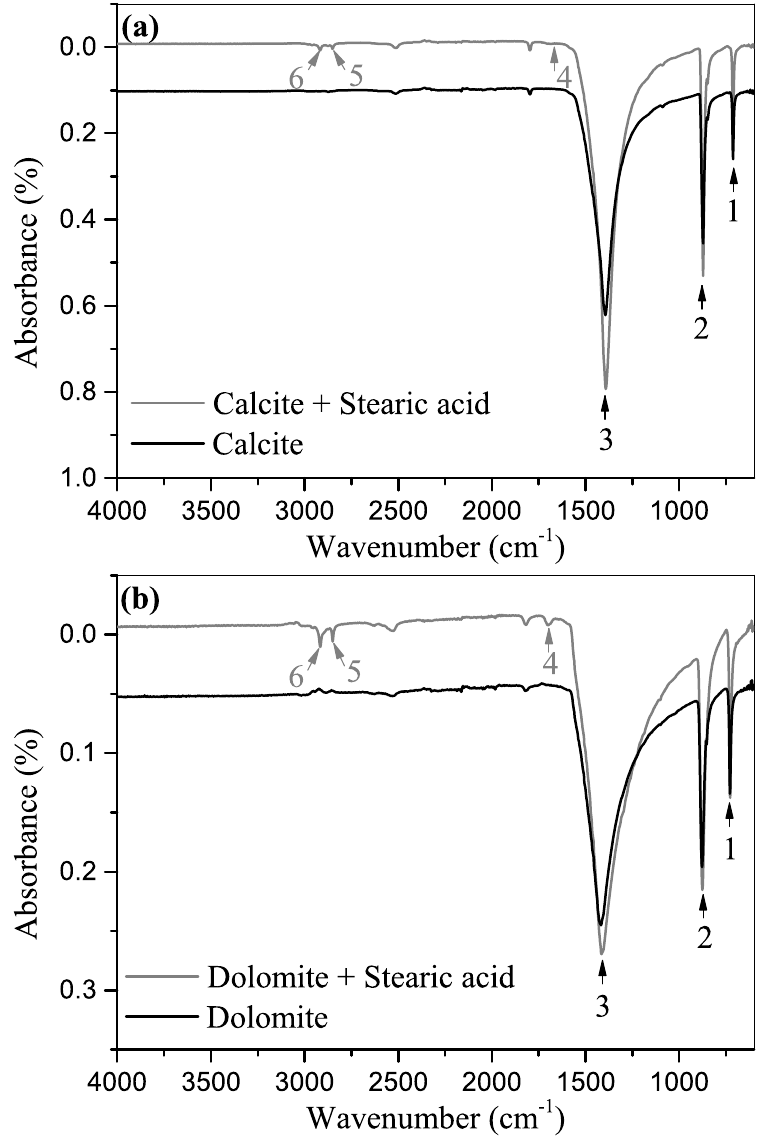
Figure 2. Comparison of Attenuated Total Reflectance Fourier Transform Infrared (ATR-FTIR) spectra of ( a ) unconditioned calcite and stearic acid-conditioned calcite and ( b ) unconditioned dolomite and stearic acid-conditioned dolomite